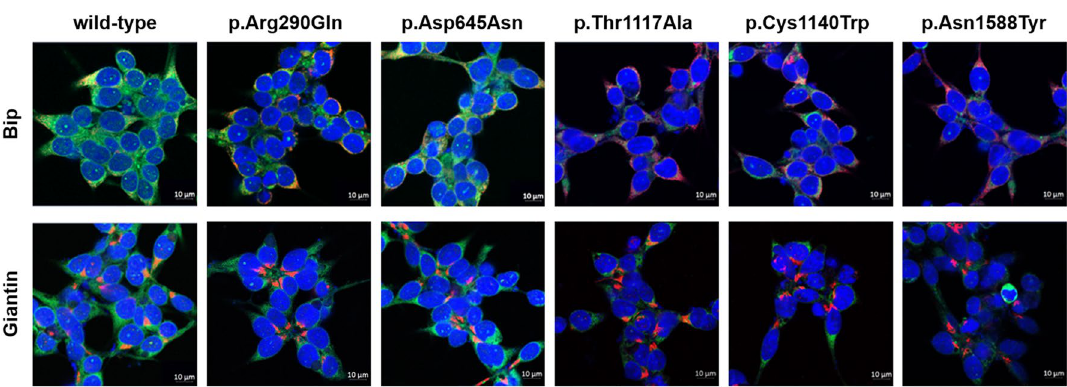
Figure 3. Effect of ABCA4 variants on subcellular localization. After transfection with ABCA4 wild-type or variant plasmids, HEK-293T cells were fixed, permeabilized, and immunostained using primary antibodies for anti-FLAG M2, BiP endoplasmic reticulum marker, or giantin Golgi marker. Scale bars, 10 was less decreased than that of the three variants, a large faction of ABCA4 was present in the endoplasmic reticulum. Frequency of ABCA4 promoter variants. Three common single nucleotide polymorphisms (SNPs) (minor allele frequency ≥ 5%)—c.-1086A>C (rs2151846), c.-900A>T (rs3789452) and c.-761C>A (rs3761906)— in the ABCA4 proximal promoter region were identified using SNP data from the database of single nucleotide